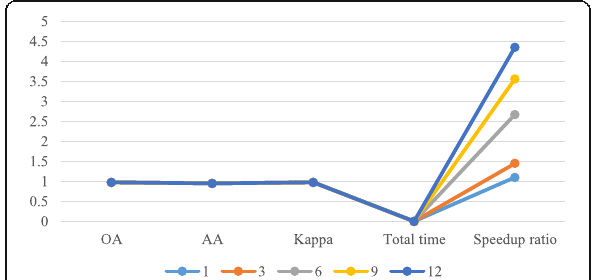
Fig. 2 Data 1 acceleration ratio performance test